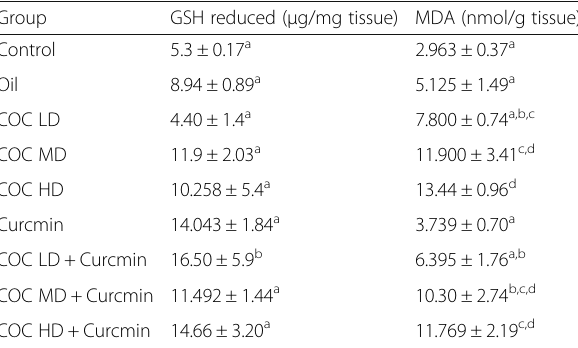
Table 2 Effects of COC and curcumin on liver GSH reduced and MDA levels in rats